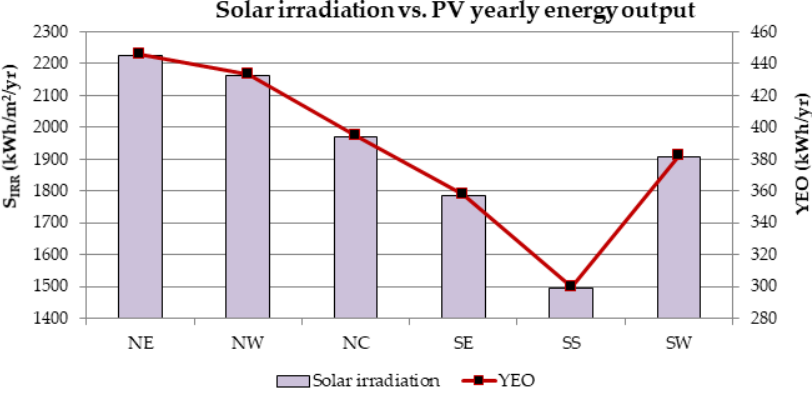
Figure 10. PV array’s yearly energy output